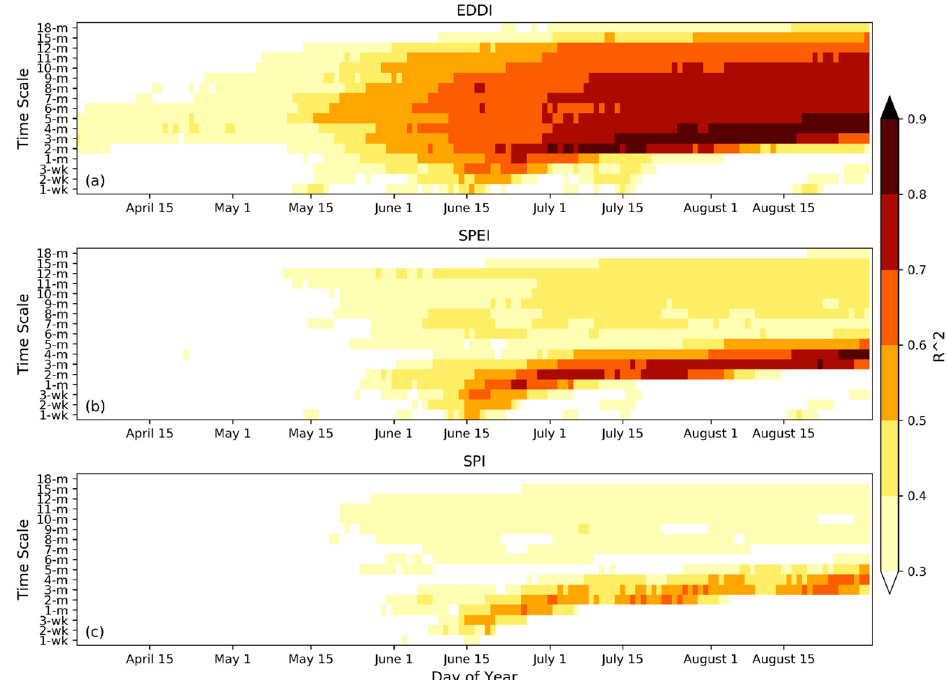
Figure 2. Average summer 1000-hr fuel moisture correlated to ( a ) the Evaporative Demand Drought Index (EDDI), ( b ) the Standardized Precipitation Evapotranspiration Index (SPEI), and ( c ) the Standardized Precipitation Index (SPI) at the Northern Sierra Nevada, California PSA. Vertical axis indicates drought index time scale in weeks (wk) or months (m) and horizontal axis shows the drought index ending day for the correlation. The zero-day lag is indicated at 31 August and the start of season lag (~90-day) is indicated at 1 June.